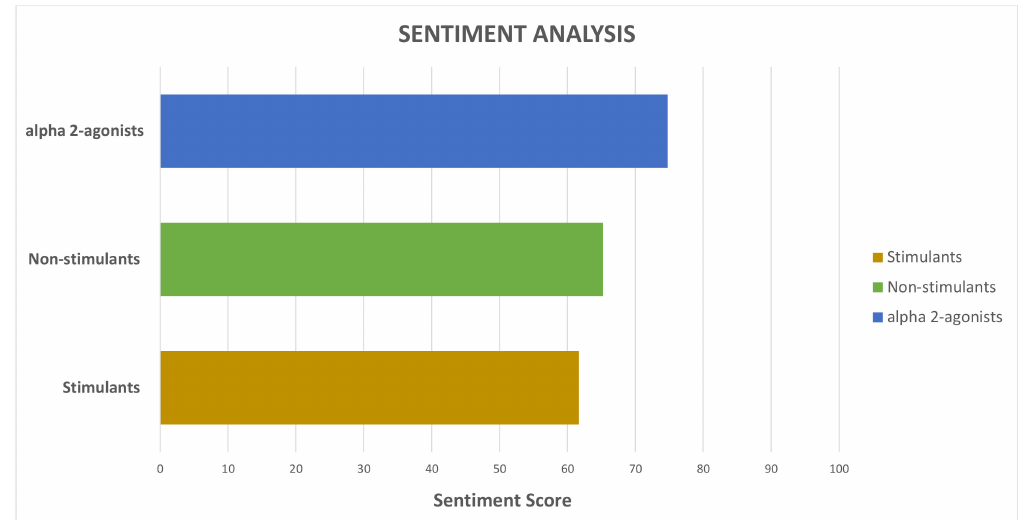
Figure 3. Sentiment score comparisons between alpha-2 agonists, non-stimulants and stimulants. Sentiment analysis is classifying the polarity of the tweet on a scale of 0 (very negative) to 100 (very